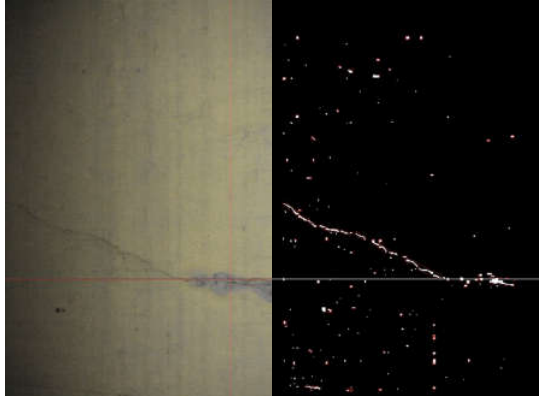
Figure 7. Illustration of the original image and the assessment over the CNN annotated one. The red bounding boxes depict the regions under inspection. The robotic arm will then move to a maximum-crack-width point, indicated by ‘+’, for further